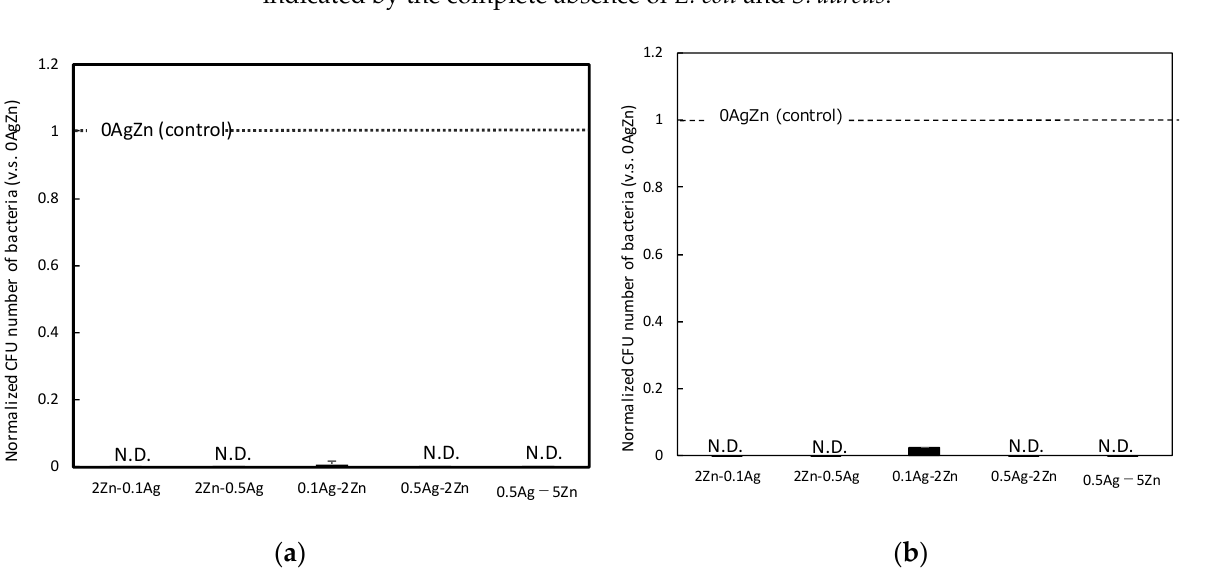
Figure 5. Amounts of ( a ) Ag and ( b ) Zn in the oxide layer measured via EDS. Measurements were performed on five equally conditioned specimens ( n = 5). Results in CFU < 1 are denoted as “N.D.”.